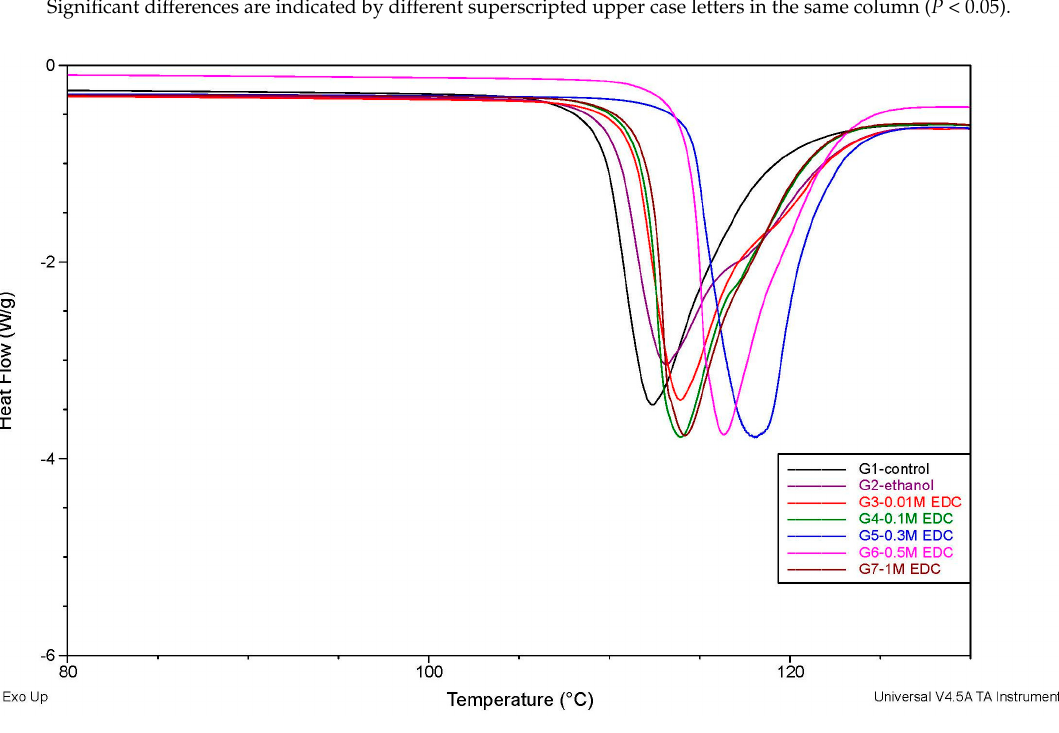
Figure 3. DSC thermograms of the demineralized dentin powder with and without EDC treatment. The first endothermal peak illustrates the thermal degradation temperature of the specimens, mainly composed of type I collagen.